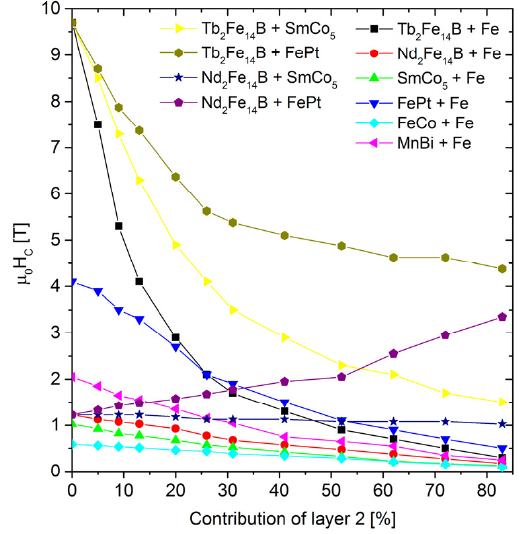
Figure 8. Saturation polarization as a function of the “layer 2” content.